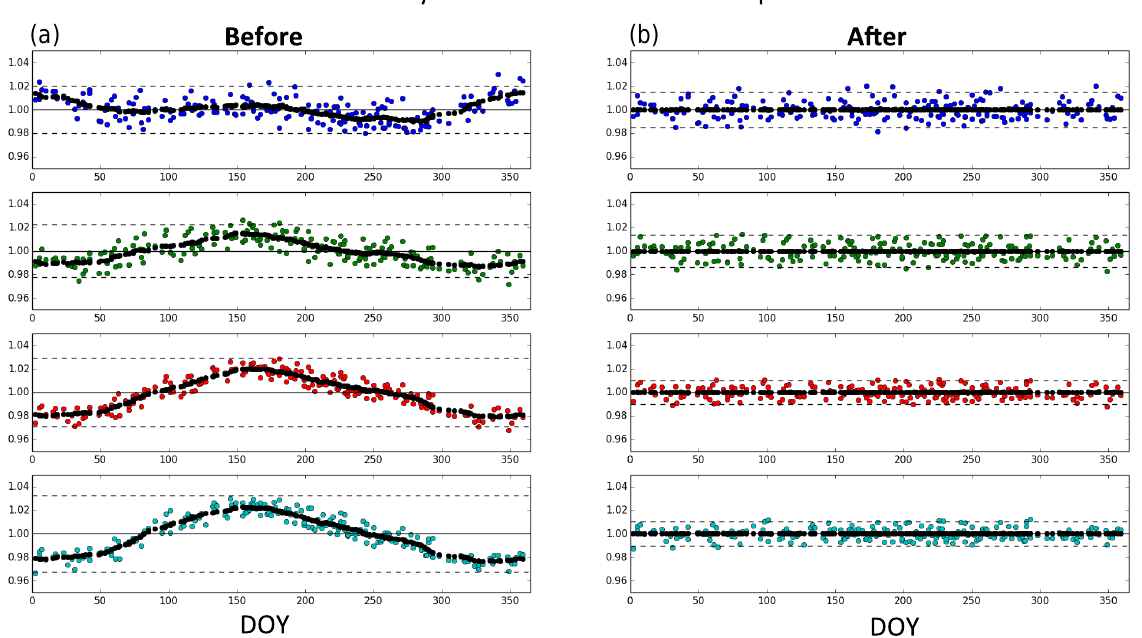
Figure A1. De-seasonalization example for Libya-4. Data are normalized such that the mean value of each time series is unity. Dashed black lines indicate ± 2 standard deviations. The plots on the left show the MISR An (nadir camera) data for the four spectral bands, after Step 2d in Appendix A2 has been performed. The plots on the right show the same data after Step 3b is complete. These plots present results for only one of two separate paths covering Libya-4 and for only one of nine cameras. Similar analysis was performed for two paths for each of the three stable desert sites.